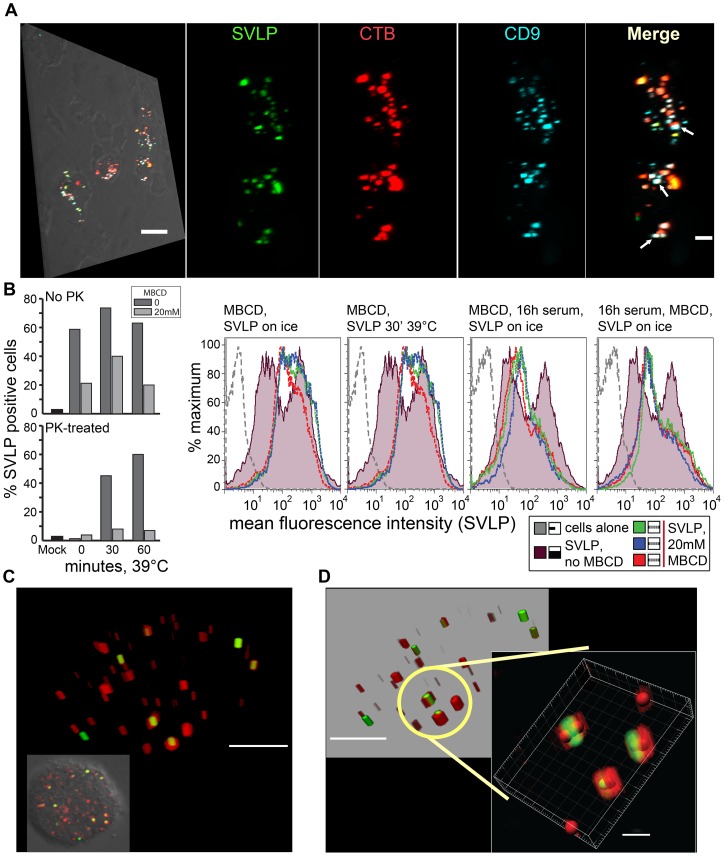
SVLP associating with early endosomes and CD9.(A) Pre-chilled DC were incubated with SVLP and CTB as in Fig. 3, or with antibody against CD-9 for 30 min on ice. Samples were then washed and shifted to 39°C for 2 hrs, followed by confocal microscopy analysis. High-resolution stacks prepared using IMARIS are shown for each label, arrows indicating co-localisation. Scale bars: 20 µm (left image), 5 µm (zooms). (B) DC were treated with 20 mM MBCD for 20 min at 39°C, followed by washing to remove the MBCD and pre-chilling for 30 min on ice. DC were then pulsed with 2.5 µg/ml SVLP for 20 min on ice (“0” time point) and then washed with pre-chilled medium, prior to receiving fresh warm (39°C) medium containing 2 mM MBCD and shifting back to 39°C. DC were treated or not with PK to define internalisation at the time points shown. Analyses were by flow cytometry; all differences at the 39°C time points between 0 MBCD and 20 mM MBCD treatment are significant, as are the differences between “No PK” and “PK-treated” for the 20 mM MBCD samples (p≤0.001). (C) DC were incubated with 2.5 µg/ml SVLP at 39°C for 10 min, then fixed/permeabilised and co-labelled with anti-EEA-1 antibody prior to confocal microscopy analysis. Scale bar: 3 µm. (D) A 3-dimensional analysis of the circle shown in (C); the right image shows a further analysis of the circle in the left image, analysed with the aid of Spots module in IMARIS to define centre points for SVLP (green) and EEA-1 (red) labelling. Scale bars: 3 µm (blend), 1 µm (zoom; spot module to enhance visualisation, filtered on mean intensity).